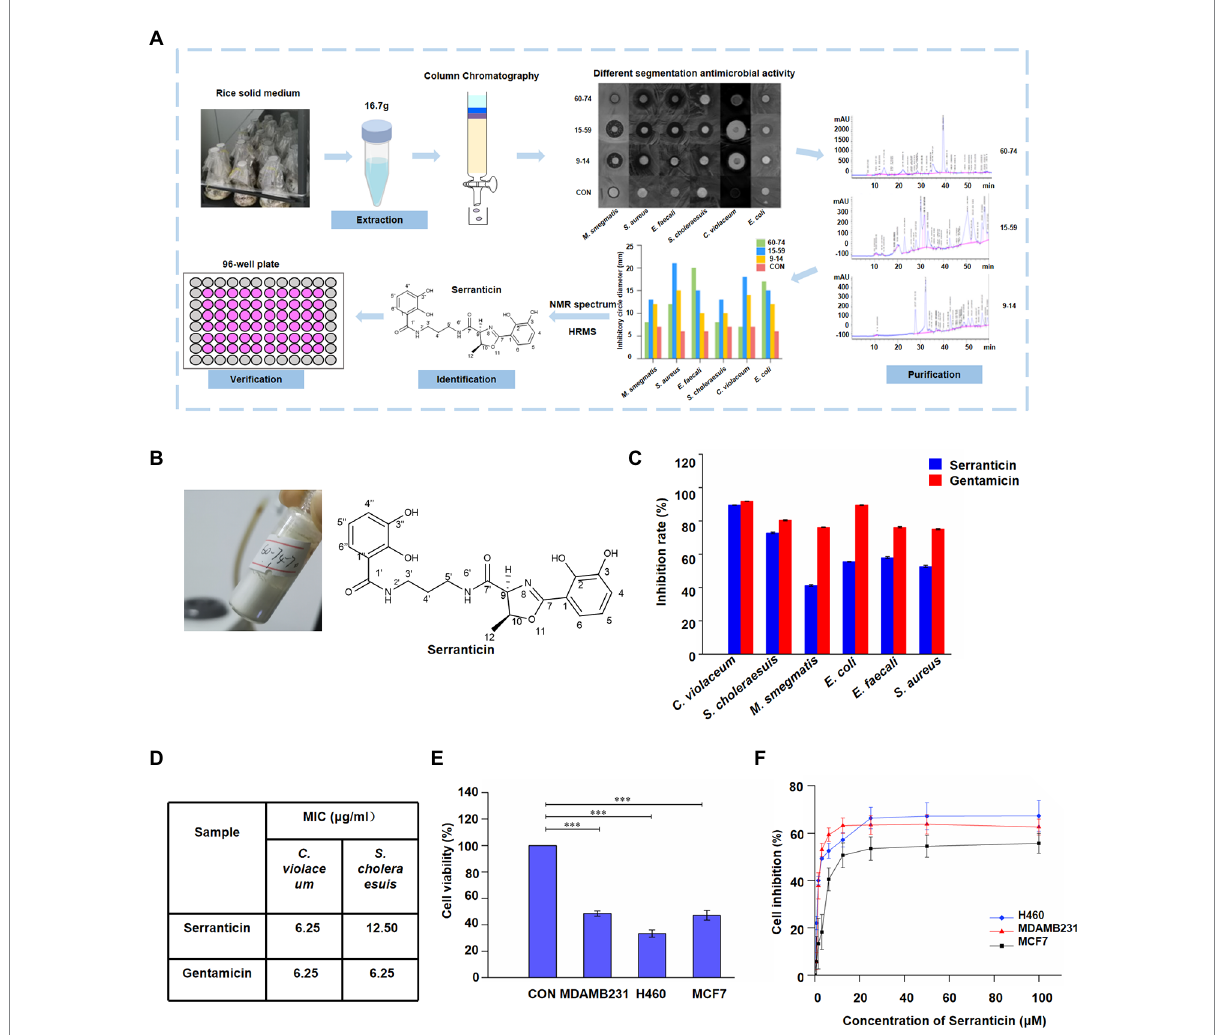
FIGURE 5 Purification and characterization of bioactive compound, serranticin. (A) , Workflow of the bioactivity-guided fractionation. (B) , Serranticin produced by Serratia L7-1 strain. ChemDraw 19.0 (C) In-vitro antimicrobial activity of the serranticin. Dates are the mean ± s.d. The experiments were repeated tree times with similar results. Blue squares serranticin, rad squares Gentamicin. (D) The MIC values for inhibition of pathogenic bacteria of serranticin and the standard Gentamicin. Origin 2022. (E) , In-vitro cytotoxicity activity of the serranticin. Dates are the mean ± s.d. The experiments were repeated tree times with similar results. Statistical significance of the test cell viability compared with the control group was determined using a two-tailed Student’s t-test; the p values were as follows:<0.0001 MDAMB231, H460, and MCF7 cells. (F) , Inhibition of cell proliferation by serranticin against H460, MDAMB231 and MCF7 cells. Dates are the mean ± s.d. The experiments were repeated tree times with similar results. Blue diamond H460, rad triangle MDAMB231, black squares MCF7. Origin